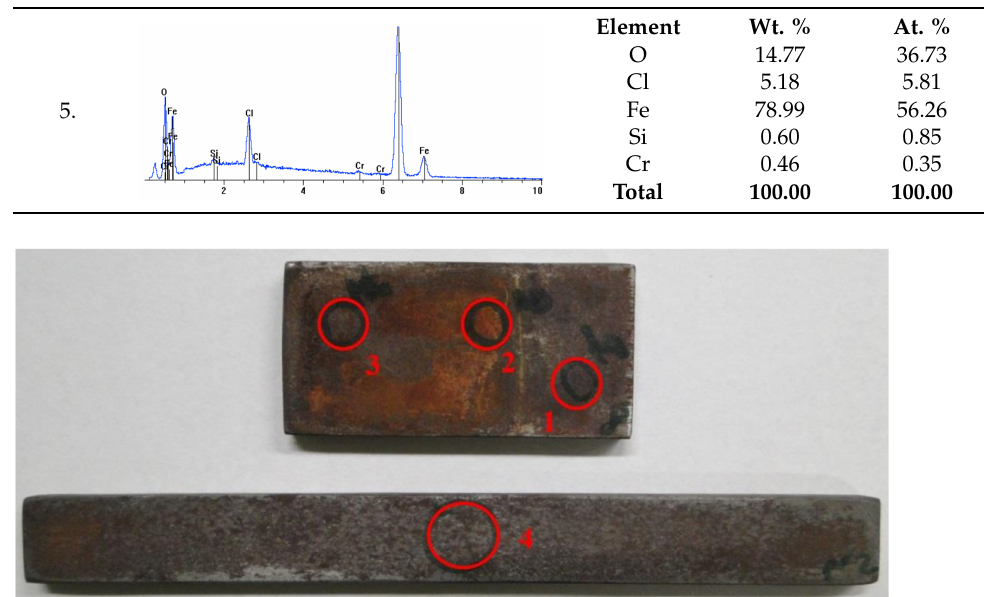
Table 4. Results of chemical composition studies in the area from Figure 8.